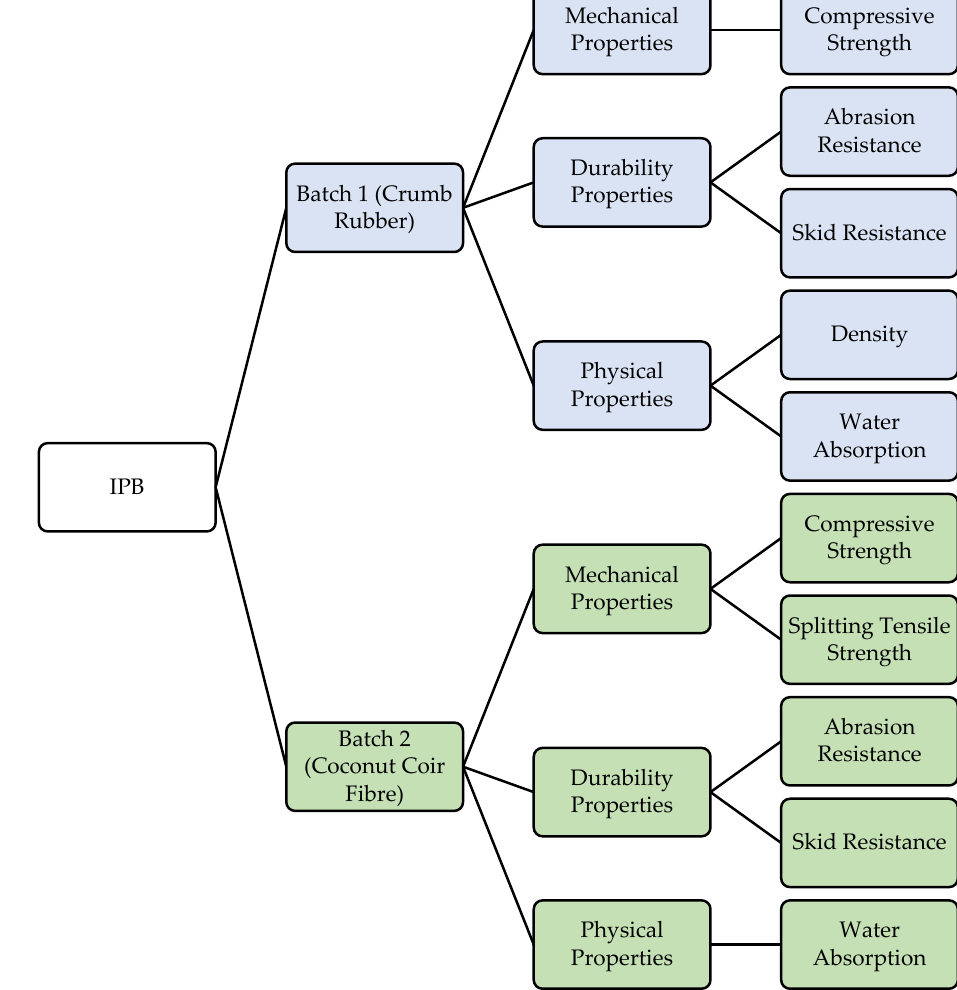
Figure 4. Experimental Procedures for the IPBs.